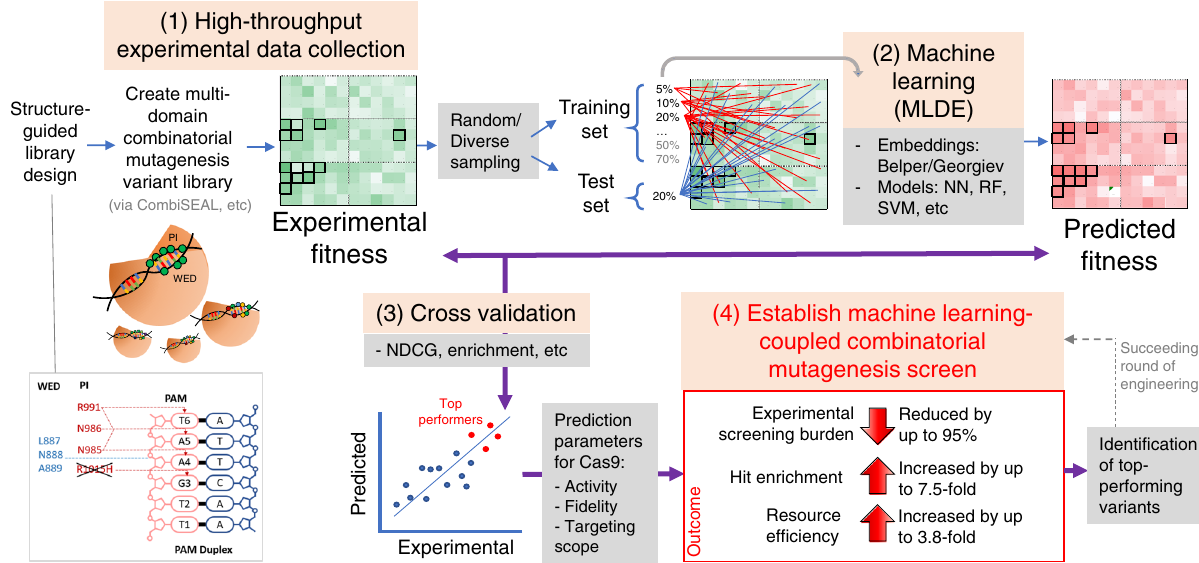
Fig. 5 Machine-learning-integrated multidomain combinatorial mutagenesis screen for resource-ef fi cient protein engineering. An overview of our study procedures and outcomes. We started with structure-guided design to select sites and residues for mutagenesis and built multidomain combinatorial variant libraries. We then run MLDE and tested embedding and model parameters to generate in silico predictions. We cross-validated experimental and MLDE predictions, which established parameters for accurate prediction of Cas9 ’ s activity, fi delity, and targeting scope. The machine-learning-coupled multidomain combinatorial mutagenesis screening approach facilitates the identi fi cation of top-performing variants with much reduced experimental screening burden, increased hit enrichment, and enhanced resource ef fi